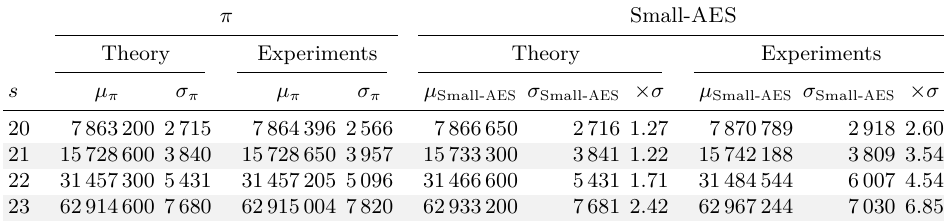
Table 3: Means and standard deviations for the number of pairs that collided in a fixed output byte for our four-round distinguisher with Small- AES in Setting (1). Each experiment employed 100 random independent keys and 2 s random δ -sets. Experimental values are rounded. Full-round Speck-64-96 was used as pseudorandom permutation π . × σ denotes ( µ ) /σ Small- AES − µ π Small- AES with respect to the theoretical values. π Small- AES Theory Experiments Theory Experiments s µ π σ π µ π σ π µ Small- AES σ Small- AES × σ µ Small- AES σ Small- AES × σ